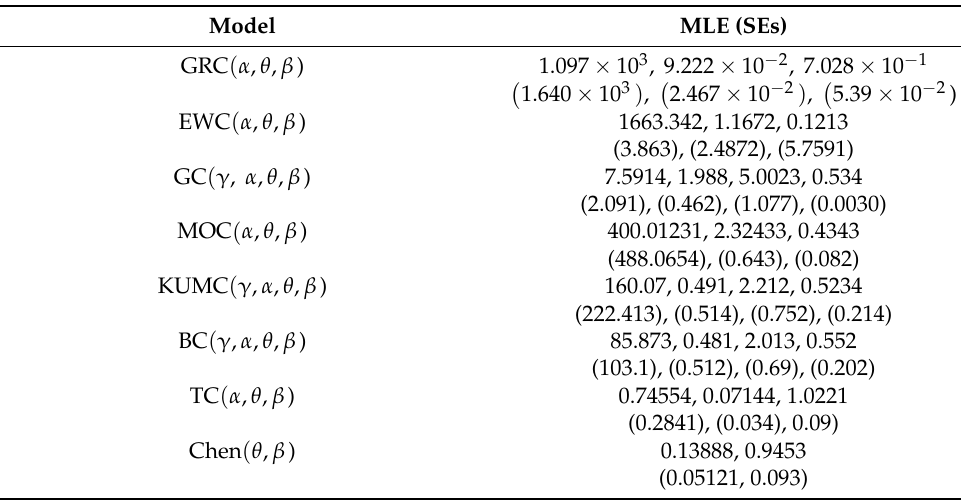
Table 2. The MLEs and their corresponding SEs for the relief data set.